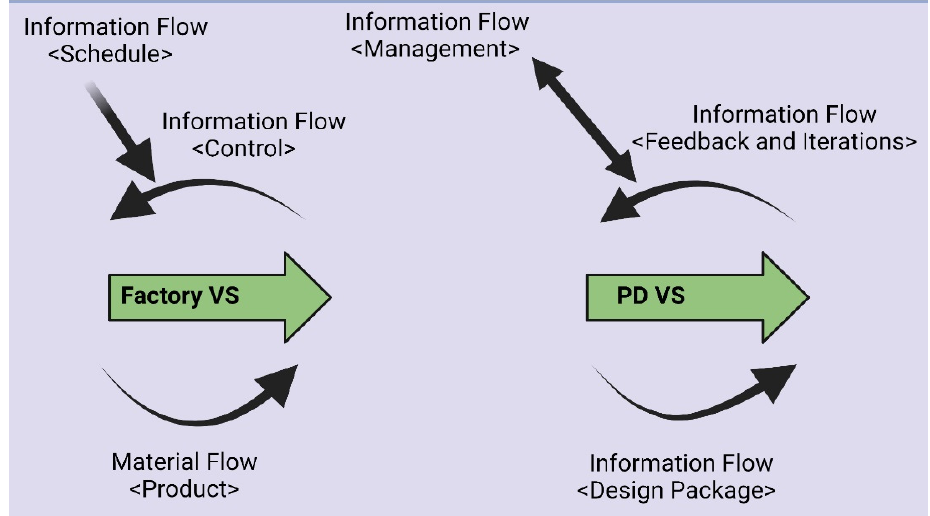
Figure 3. Adapting VSM for NPD/NPI processes [75].